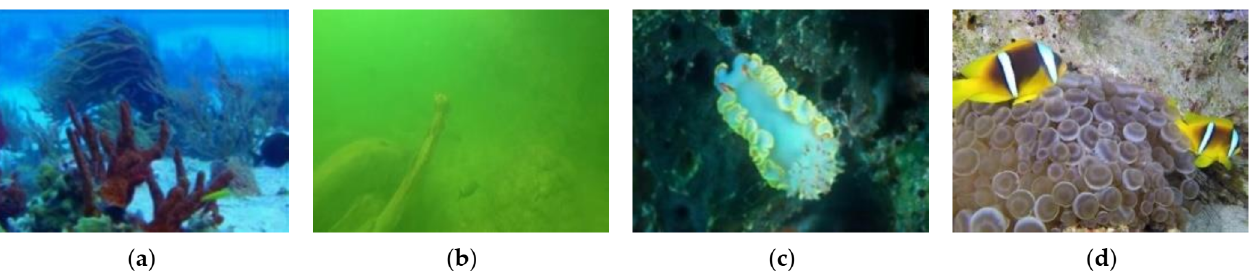
Figure 1. Underwater images with different degradation conditions. ( a ) An underwater image with bluish color deviation. ( b ) An underwater image with low contrast. ( c ) An underwater image with insufficient illumination. ( d ) An underwater image with no visible